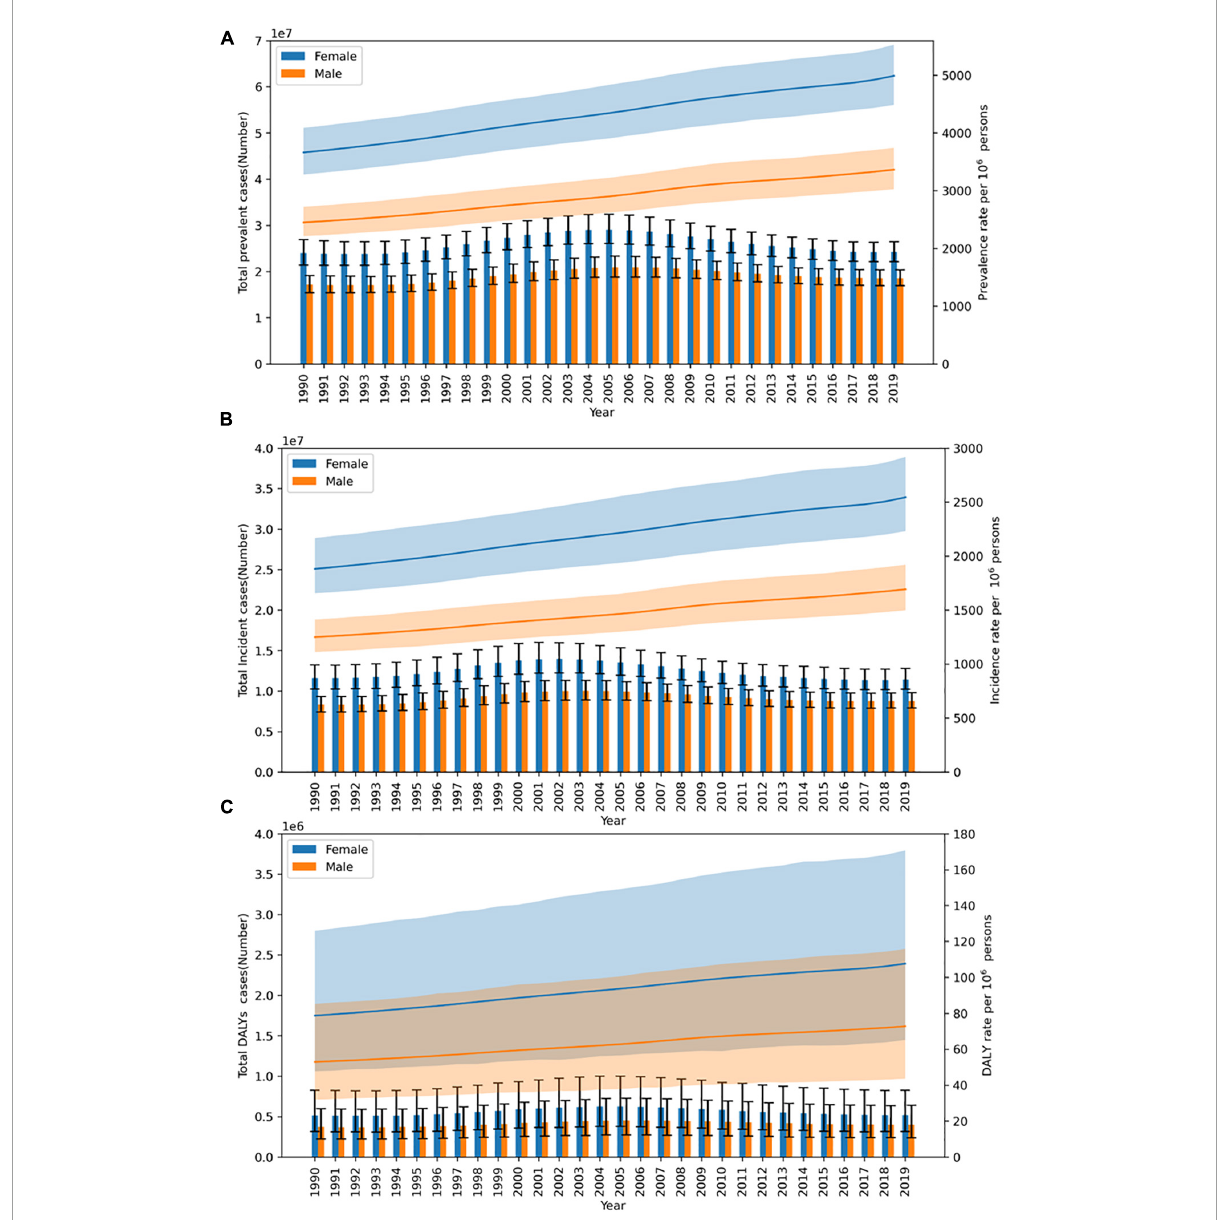
FIGURE1 Trends of acne vulgaris in China from 1990 to 2019. (A) Prevalent cases and rate. (B) Incidence cases and rate. (C) Disability-adjusted life years (DALYs) cases and DALY